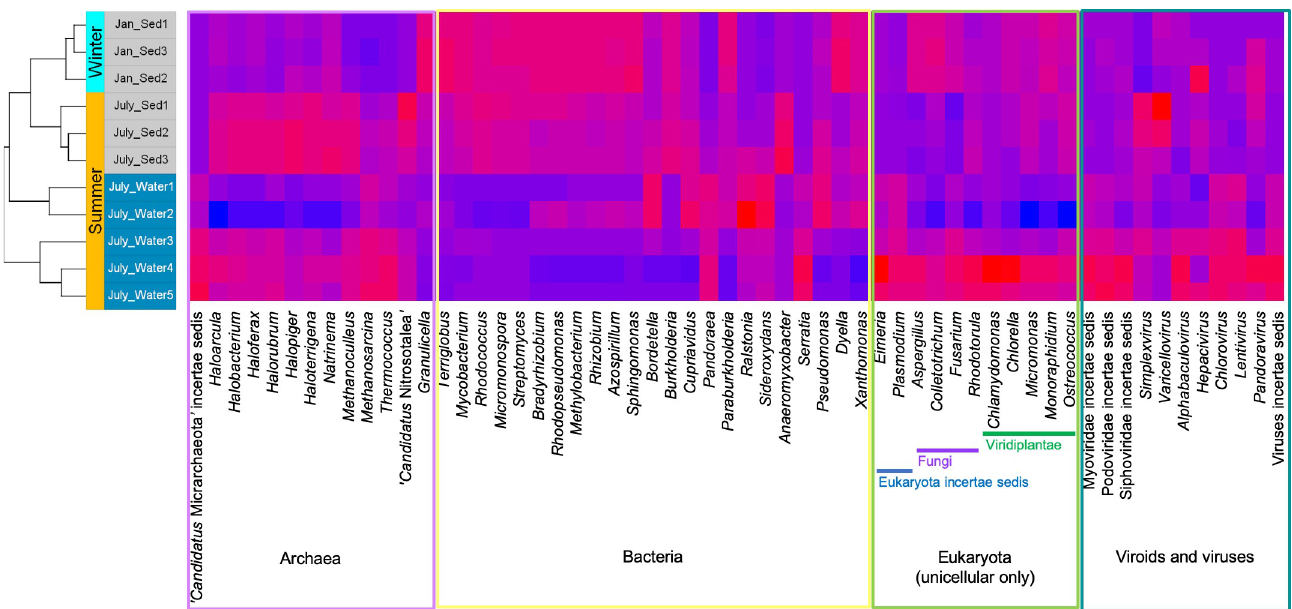
Fig 3. Seasonal microbial diversity. Relative abundances of the most abundant genera of archaea (top twelve), microbial eukaryota (top eleven), and viroid/ viruses (top eleven) as well as the 24 most abundant genera for bacteria per sample. The most abundant taxa per sample varied within each grouping (archaea, eukaryota, viroid/viruses, and bacteria). Red and blue represent high and low abundance, respectively. Incertae sedis corresponds to a taxonomic group with unknown broader relationships to other taxa.